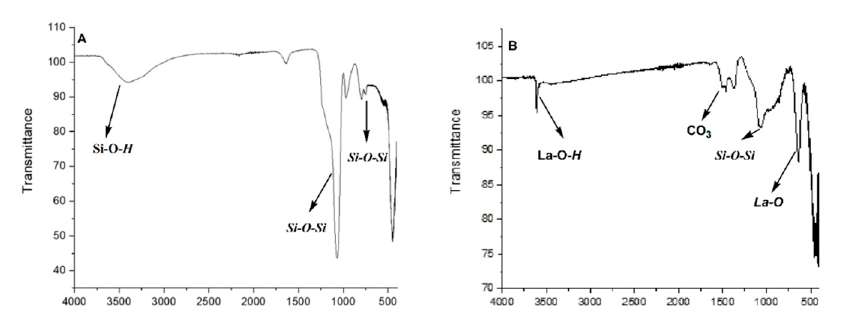
Figure 1. ATR-FTIR (Attenuated total reflection-Fourier transform infrared spectroscopy) spectra of ( A ) KIT-6 and ( B ) catalyst La(III)O-KIT-6 ( 2 ). After the reaction, catalyst ( 2 ) was brown; then, it was washed several times with methanol and was again calcined at 700 °C and reused for a new cycle. After three cycles, the catalyst continued to show the signals of CO 3 − 2 , while an intensity of the bands of La-OH and La-O lower than the fresh catalyst ( 2 ) was obtained (Figure 2).